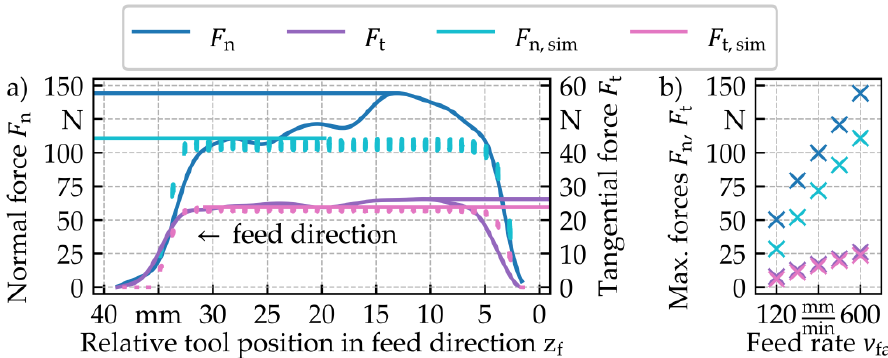
Figure 13. ( a ) Comparison of metrologically recorded and simulated ITG process forces in the industrial setting at v fa = 600 mm/min. ( b ) Maxima of tangential and normal forces depending on feed rate. Process conditions are given in Table 1.